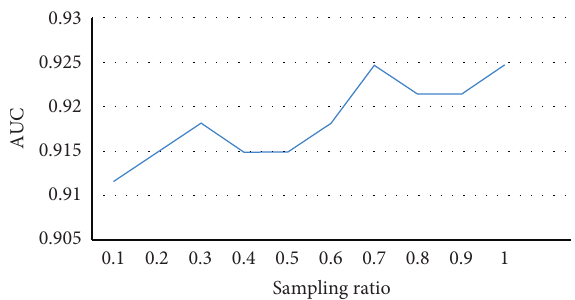
Figure 7: AUC value for kNN-SMOTE-LSTM under different sampling ratios. Table 7: Comparison of detection results of unbalanced algorithm.